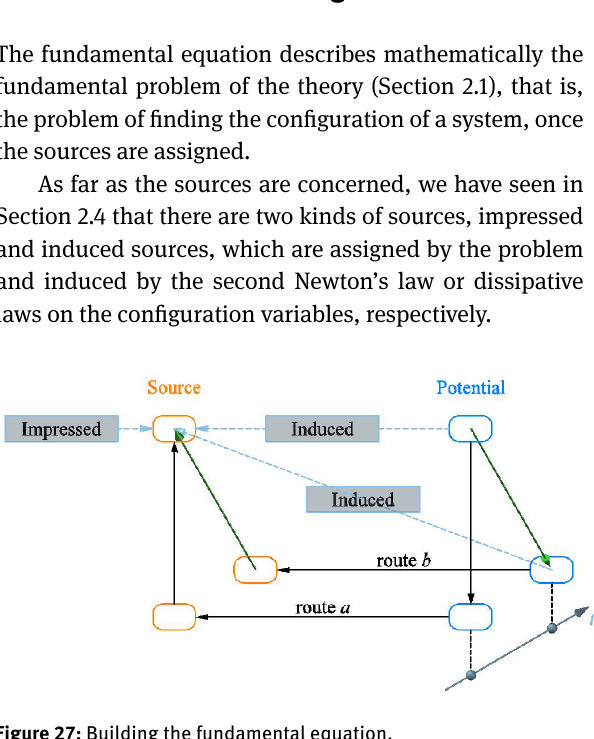
Figure 27: Building the fundamental